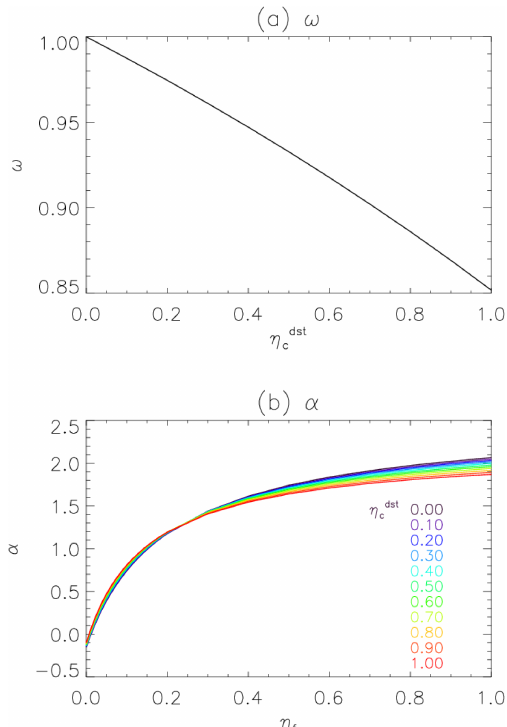
Figure B1. The relations of (a) single-scattering albedo at 500nm ( ω ) and (b) Ångström exponent between 400 and 600nm ( α ) with the external mixing ratio of dry-volume concentration of fine parti- cles ( η f ) and the external mixing ratio of the dry-volume concentra- tion of dust particles for the coarse model ( η dst c ). Each color repre- sents a different η dst c